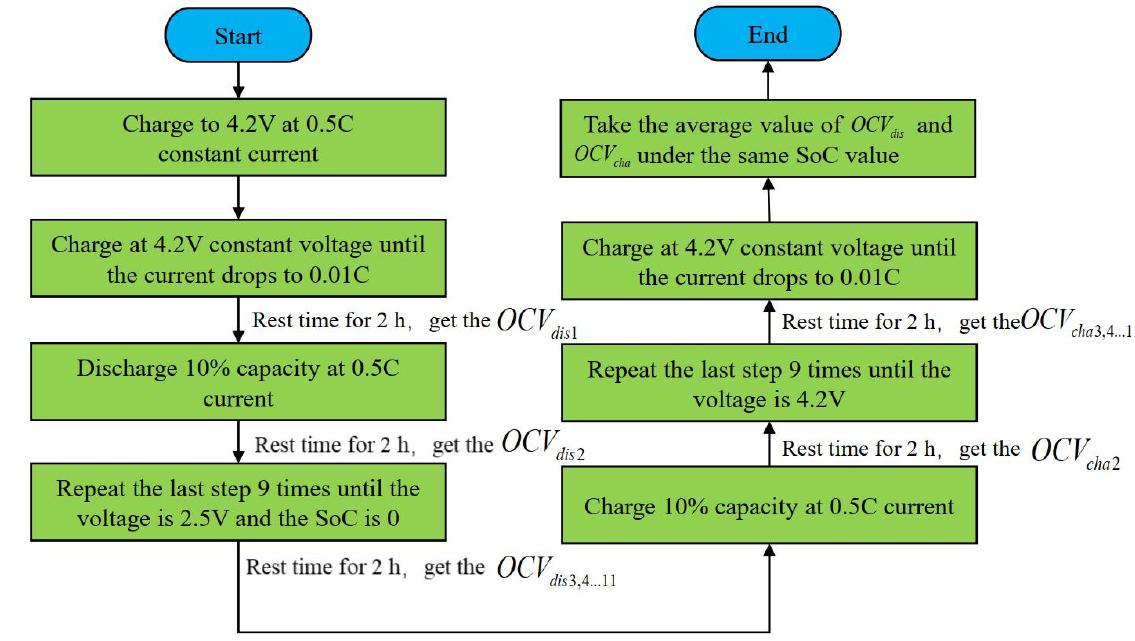
Figure 1. Schedule of the charge and discharge tests.